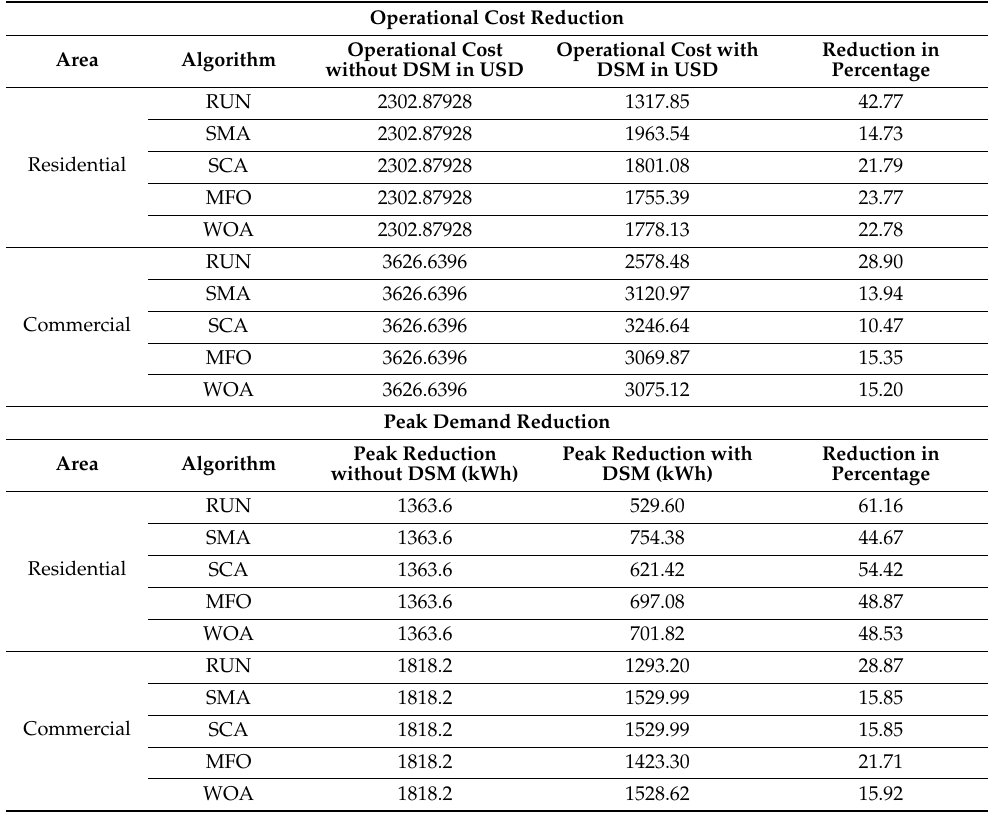
Figure 8. Strategic conservation curves for commercial consumers. Table 4. Operational cost and peak demand reduction due to strategic